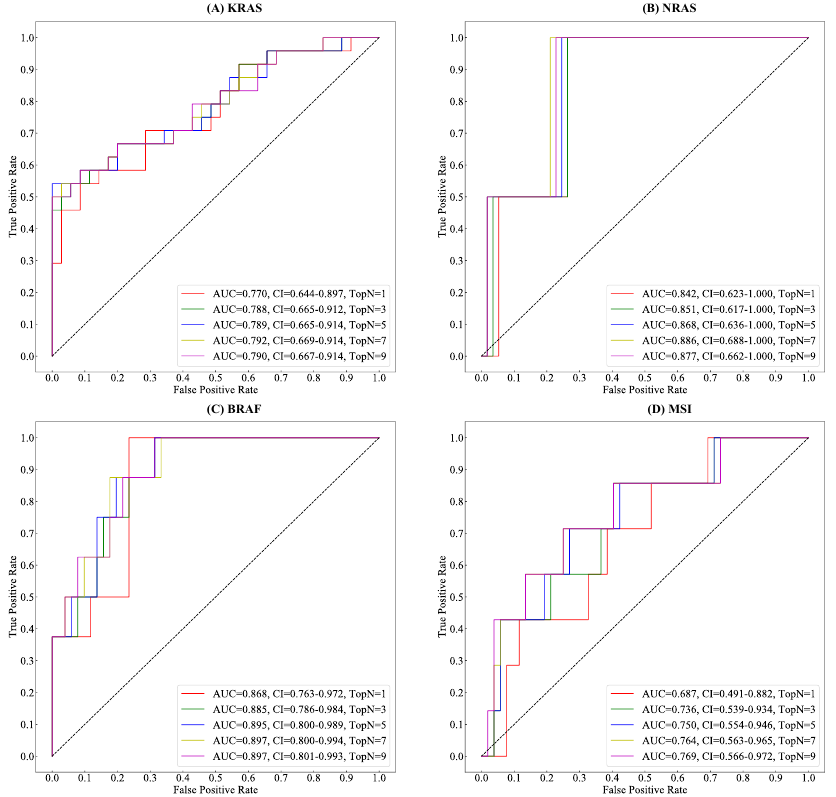
Figure 8. The receiver operator characteristic (ROC) curve and area under the curve(AUC) of Gene&MSI classification using sequential values of topN. ( A ) The trend of KRAS gene mutation classification. ( B ) The trend of NRAS gene mutation classification. ( C ) The trend of BRAF gene mutation classification. ( D ) The trend of MSI status